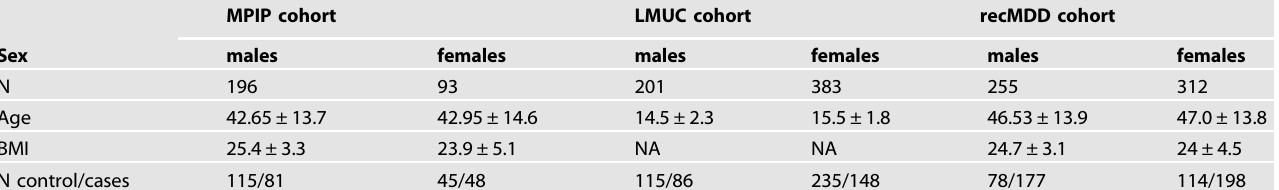
Table 1. Clinical characteristics. For continuous data the mean ± standard error and for categorical data the categories separated by dashes are given for females and